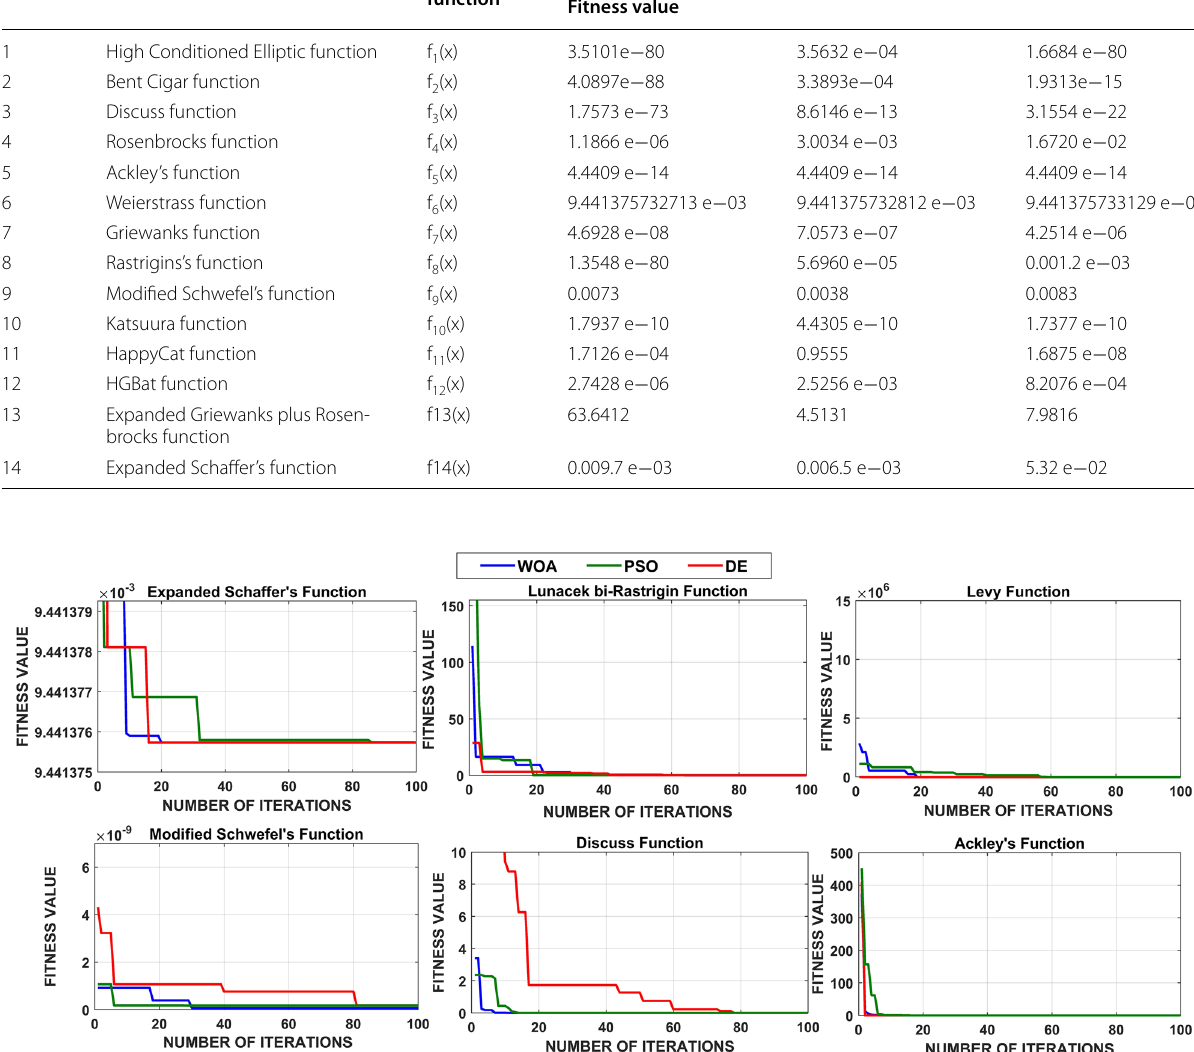
Table 4 Test results of CEC 14 test functions S.